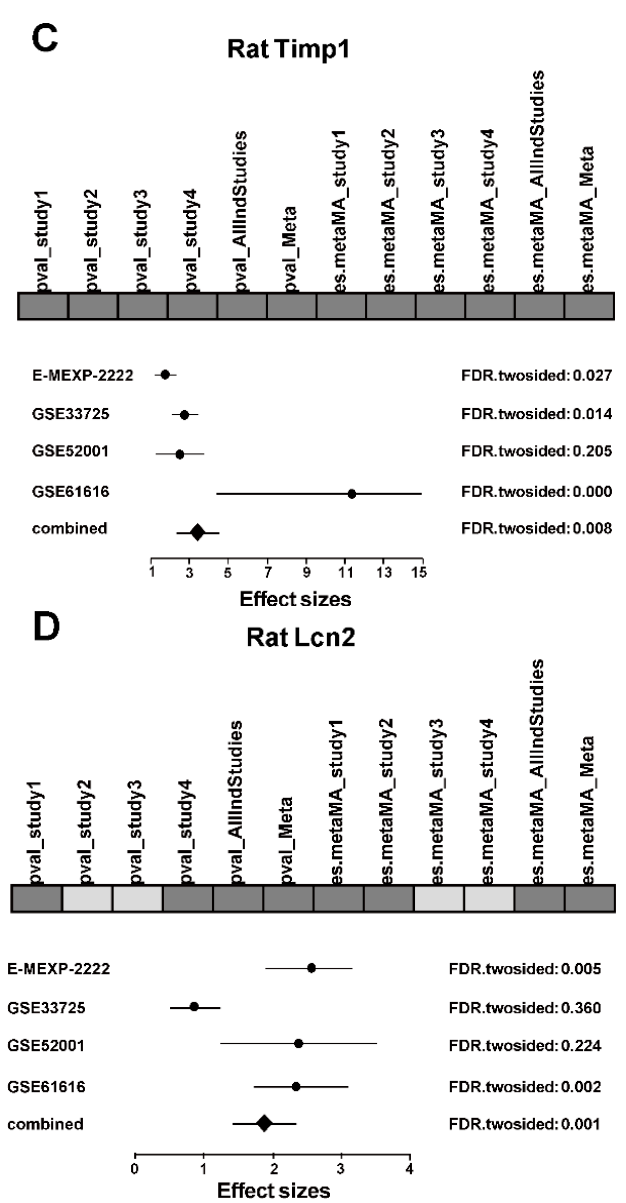
Figure 3. Forest plots of Timp1 and Lcn2. Forest plots of ( A ) Timp1 in Mus musculus ; ( B ) Lcn2 in Mus musculus ; ( C ) Timp1 in Rattus norvegicus ; and ( D ) Lcn2 in Rattus norvegicus . For each forest plot, the bar at the top shows the occurrence of combining p -values and combining effect size methods in selected genes. The dark gray box means that the result of the particular method in the selected gene is present, while light gray means that it is absent. The graph at the bottom shows the combination of effect size. The point marks the effect size, the horizontal lines denote the variance of effect size. Adjusted FDR (false discovery rate) on the right side of the graph presents the statistical significance of the difference in gene expression.